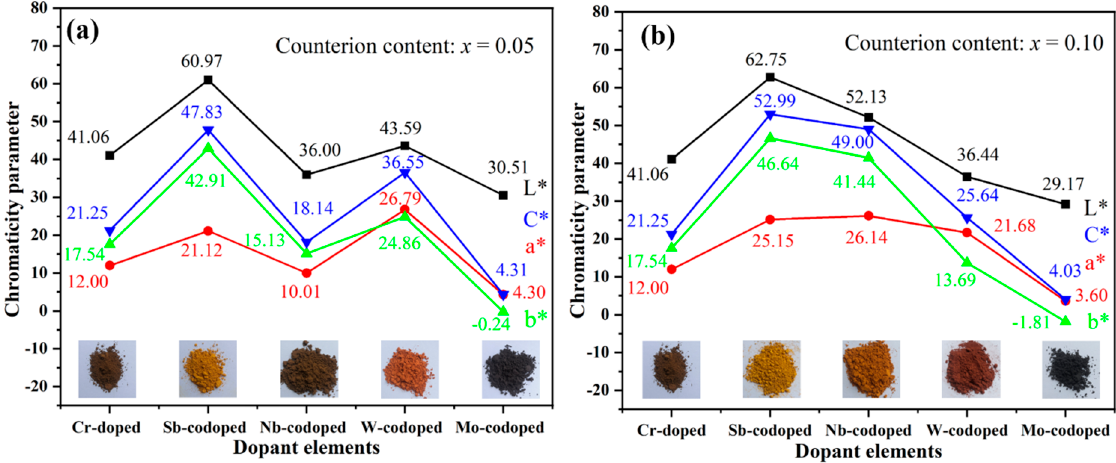
Figure 3. CIELab chromaticity parameters of Ti 0.9 − x Cr 0.1 M x O 2 pigments codoped with different counterions and calcined at 1100 °C for 2 h: ( a ) x = 0.05; ( b ) x = 0.10.